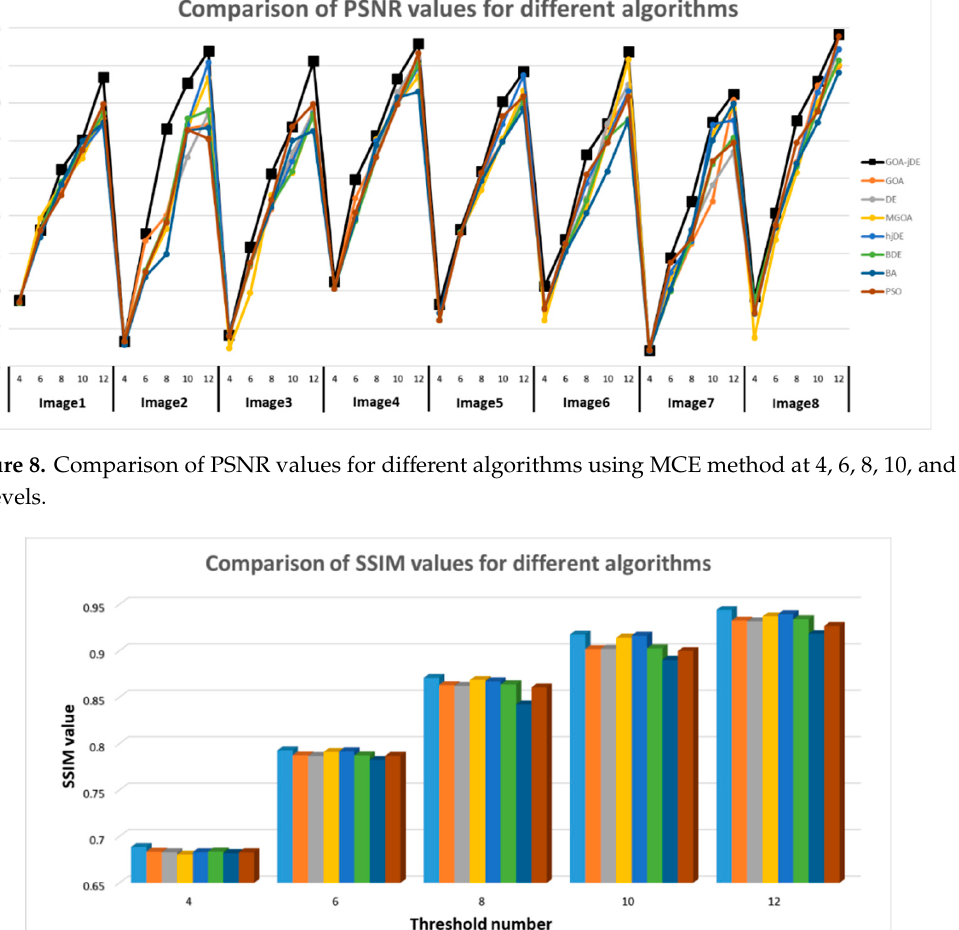
Figure 10. Comparison of FSIM values over all images using MCE method at 4, 6, 8, 10, and 12 levels. Table 6. The SSR values using MCE method compared with other algorithms. Image s